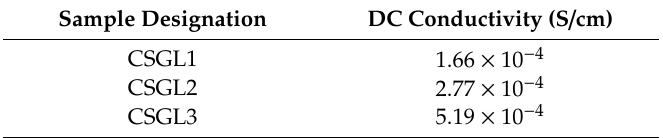
Table 1. Calculated DC conductivity for CS:LiCO 2 CH 3 :Gly electrolyte films at room temperature. Sample